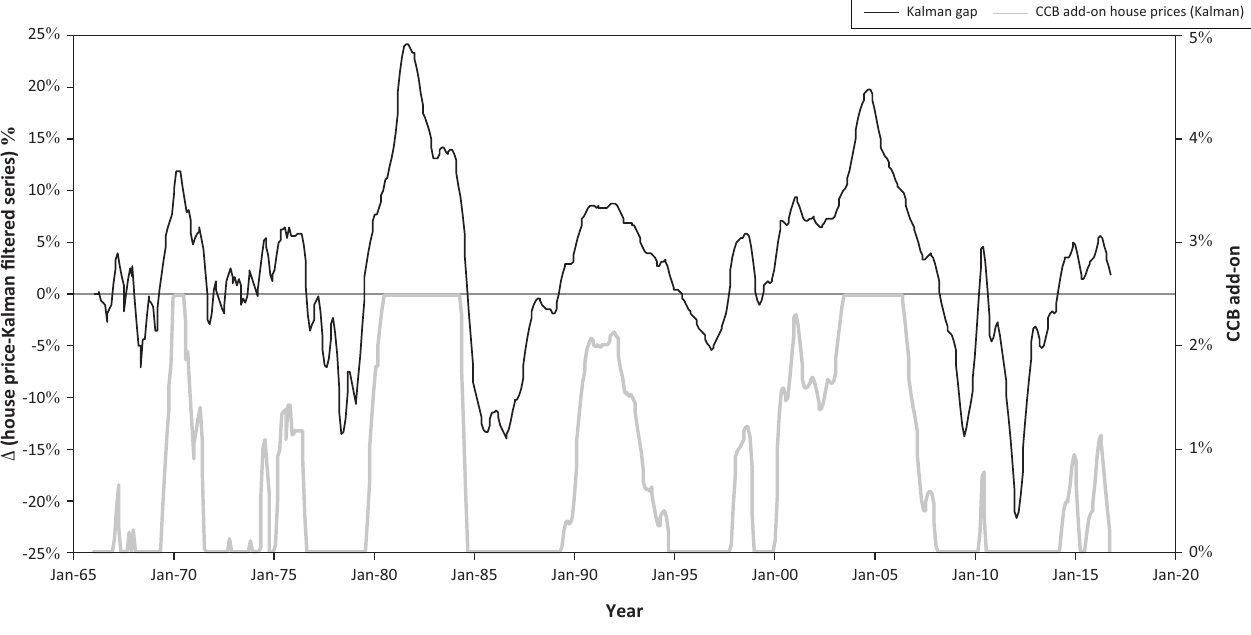
FIGURE 8: Small residential gap using the Kalman filter and Countercyclical Capital Buffer capital charge